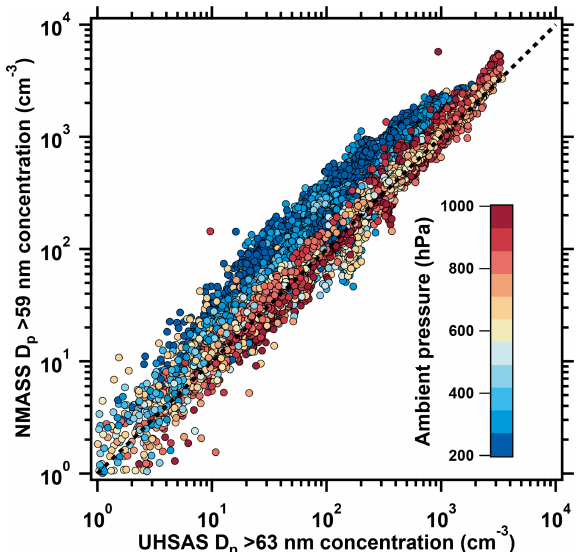
Figure 8. The 10s particle number concentration from the largest NMASS CPC channel as a function of the concentration measured by the non-thermodenuded UHSAS for all of the ATom-1 deploy- ment. Line is the 1 : 1 ratio. The NMASS concentrations are higher than the UHSAS concentrations at lower pressures because the aerosol size distribution is more steeply sloped toward smaller parti- cles, while within the boundary layer the accumulation mode dom-